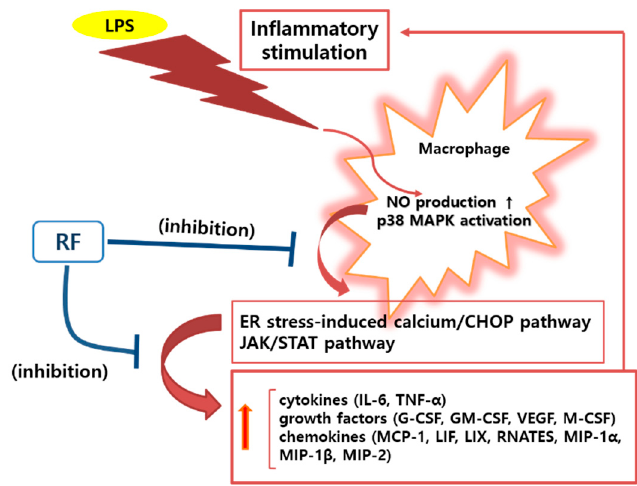
Figure 5. A schematic diagram of the immunoregulatory activity of Rubi Fructus water extract (RF) on lipopolysaccharide (LPS)-stimulated RAW 264.7 macrophages. RF alleviates LPS-stimulated macrophage activation via an ER stress-induced calcium/CHOP signaling pathway and the JAK/STAT pathway.